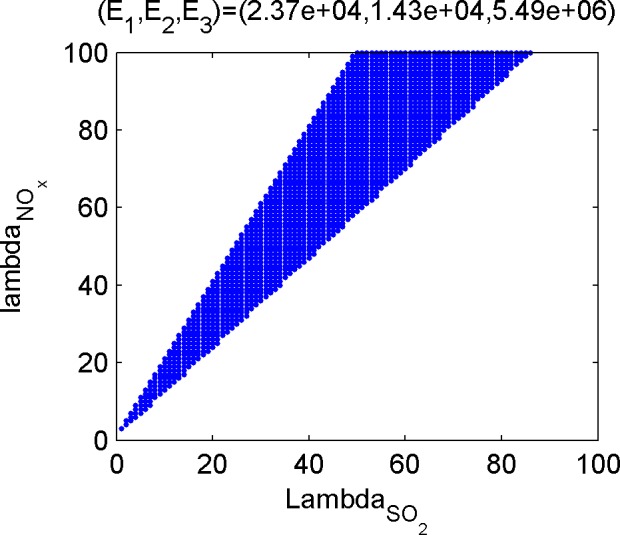
The dominant set relevant for (E1,E2,E3) = (2.37e+04,1.43e+04,5.49e+06).